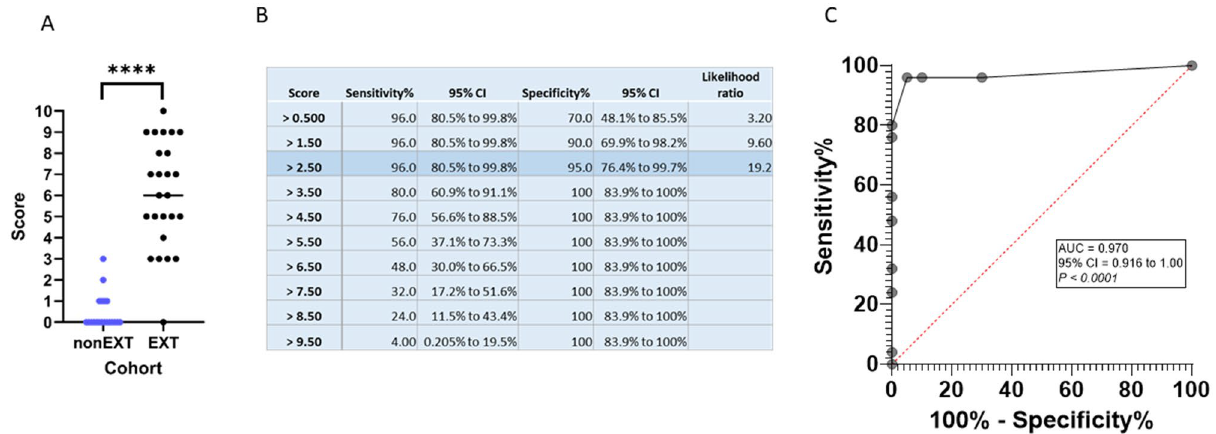
Figure 4. Sensitivity and Specificity analysis. ( A ) Plot of scores derived for Focal-PNI and Non-PNI specimens combined (nonEXT) versus EXT-PNI specimens from the data shown in Fig. 3, ( B ) data table showing sensitivity and specificity at various cut-off scores, and ( C ) the receiver operating characteristic (ROC) curve. AUC and sensitivity and specificity were analyzed and ROC curve generated using the ROC curve function on GraphPad Prism (ver 8.4.3). **** p <